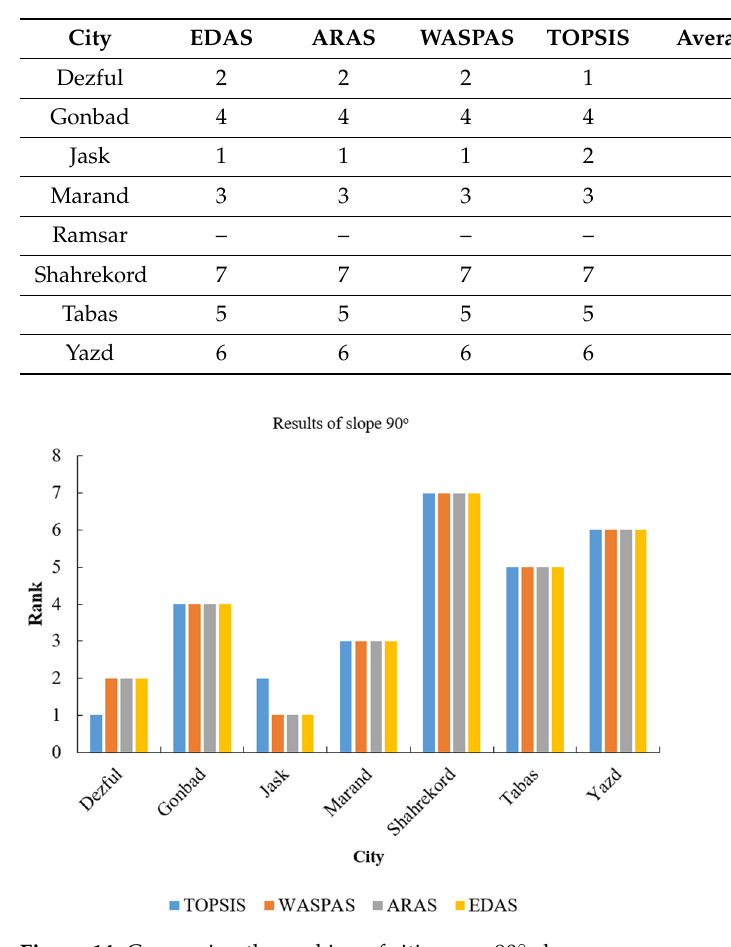
Figure 14. Comparing the ranking of cities on a 90° slope.